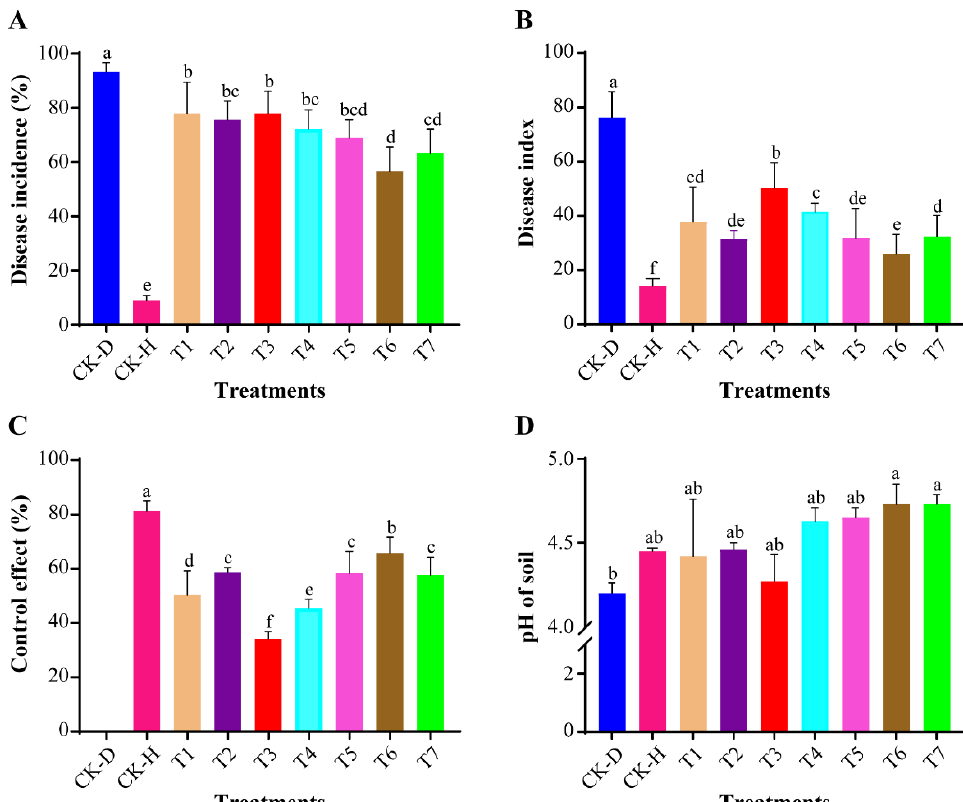
Figure 1. Biocontrol potential of candidate biocontrol strains as single strains, intra/inter-genus co-culture, and microbial consortia against clubroot disease of Chinese cabbage. Disease incidence ( A ), disease index ( B ), control effect ( C ), and pH ( D ). Different small letters on the error bars are shown the significant difference among treatments according to Duncan ’ s multiple range test at p < 0.05. Disease control (CK-D), healthy control (CK-H), single-strain Lysobacter antibioticus 13-6(T1), single-strain L. capsici ZST1-2 (T2), single-strain Bacillus cereus BT-23 (T3), intra-genus co-culture of L. antibioticus 13-6 + L. capsici ZST1-2 (T4), inter-genus co-culture of L. antibioticus 13-6 + B. cereus BT-23 (T5), microbial consortia B. cereus BT-23 + L. antibioticus 13-6 + L. capsici ZST1-2 (T6), and commercial fungicide Kejia (T7).